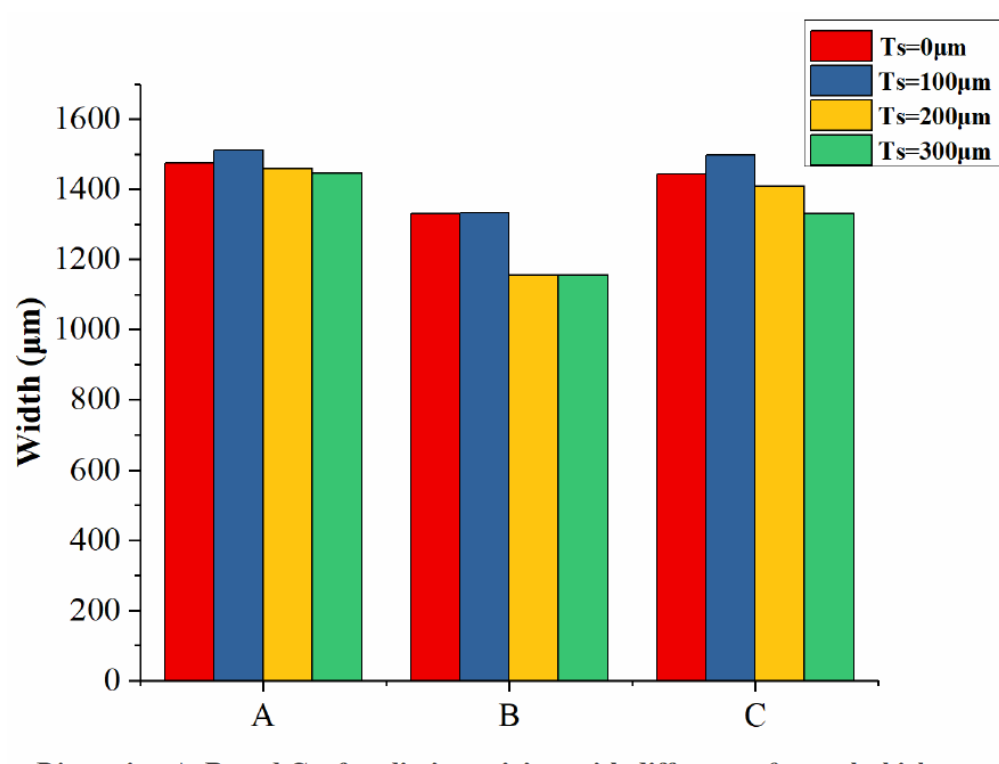
Figure 6. Dimension A, B, and C of preliminary joints with four different soft punch thicknesses.